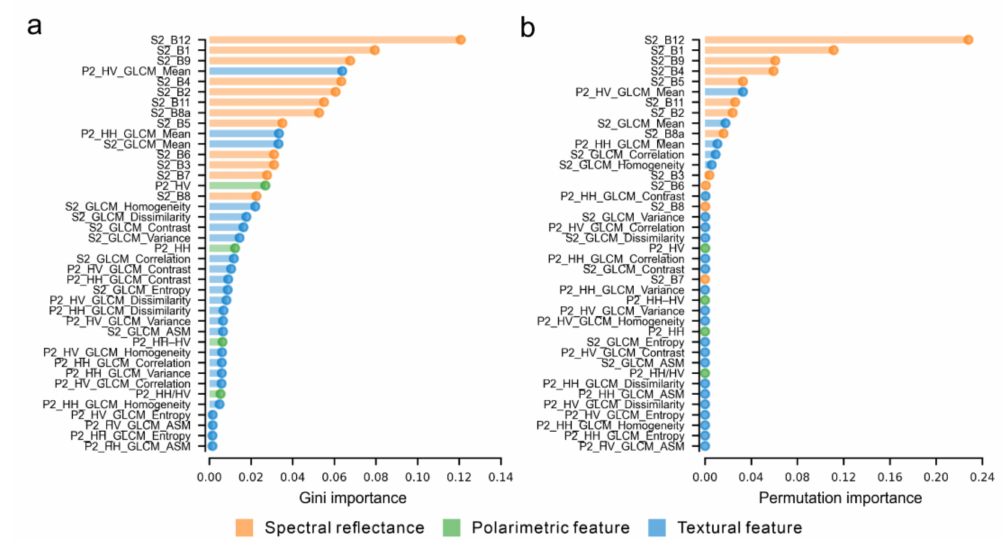
Figure 9. ( a ) Gini importance and ( b ) permutation importance of 40 input features for the RF model using the training set (D6). (S2: Sentinel-2. P2: